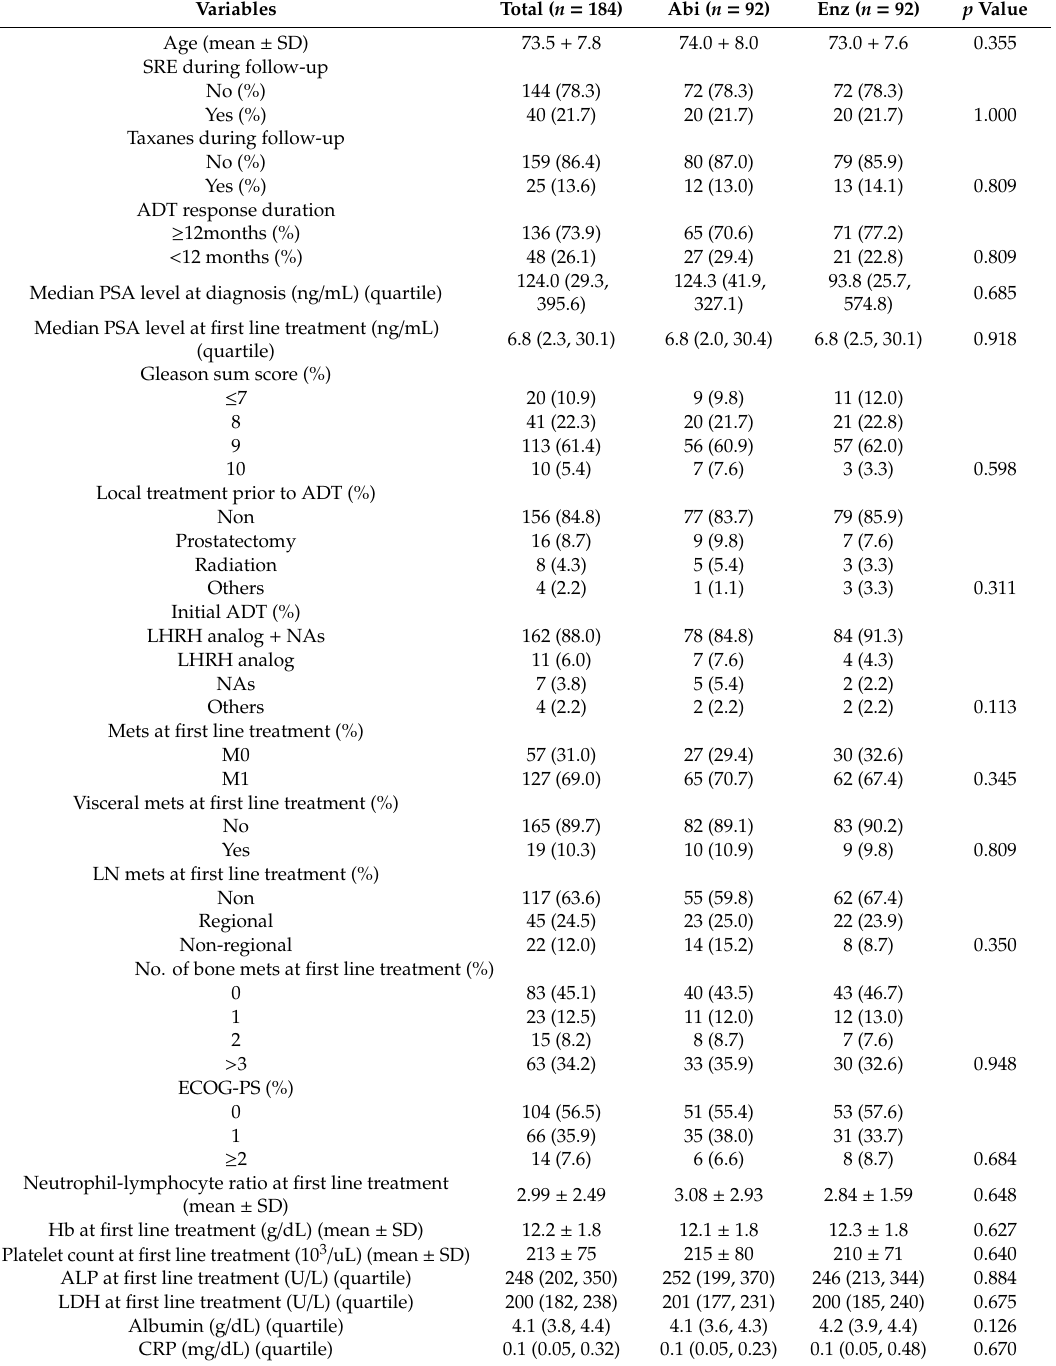
Table 1. Clinical characteristics in 184 CRPC patients adjusted by propensity score